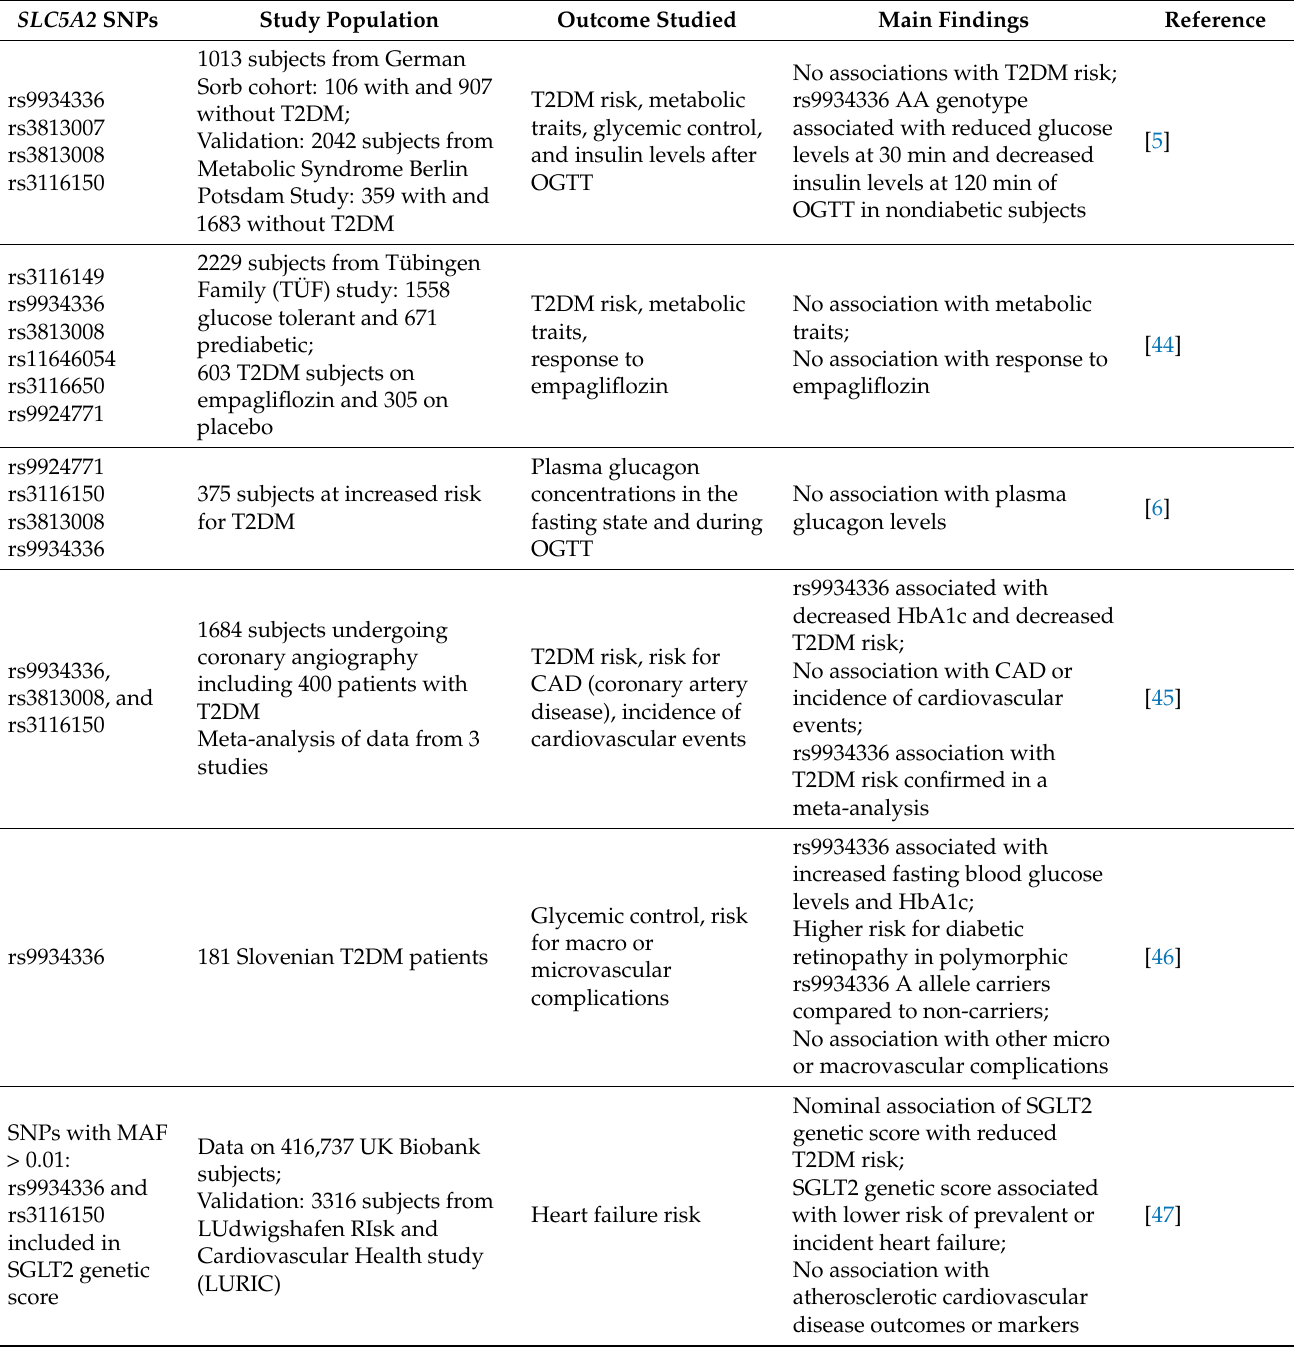
Table 2. SGLT2 genetic variability in T2DM and in treatment with SGLT2